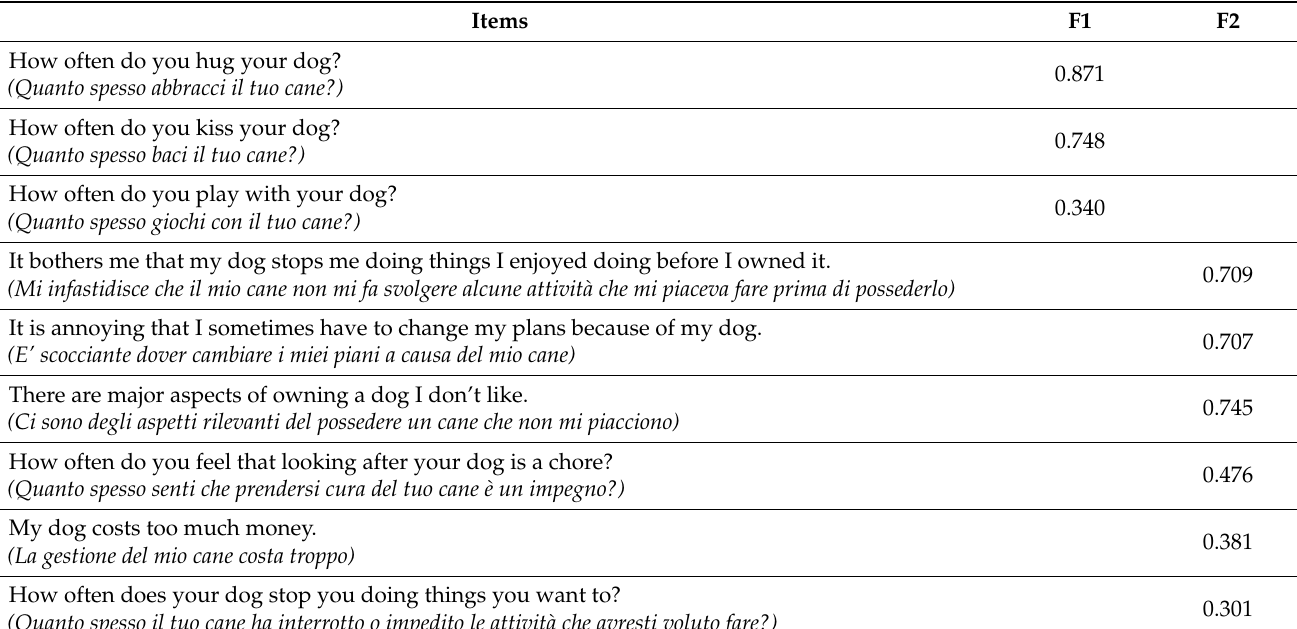
Table 1. Factor loading for the two subscales of the MDORS